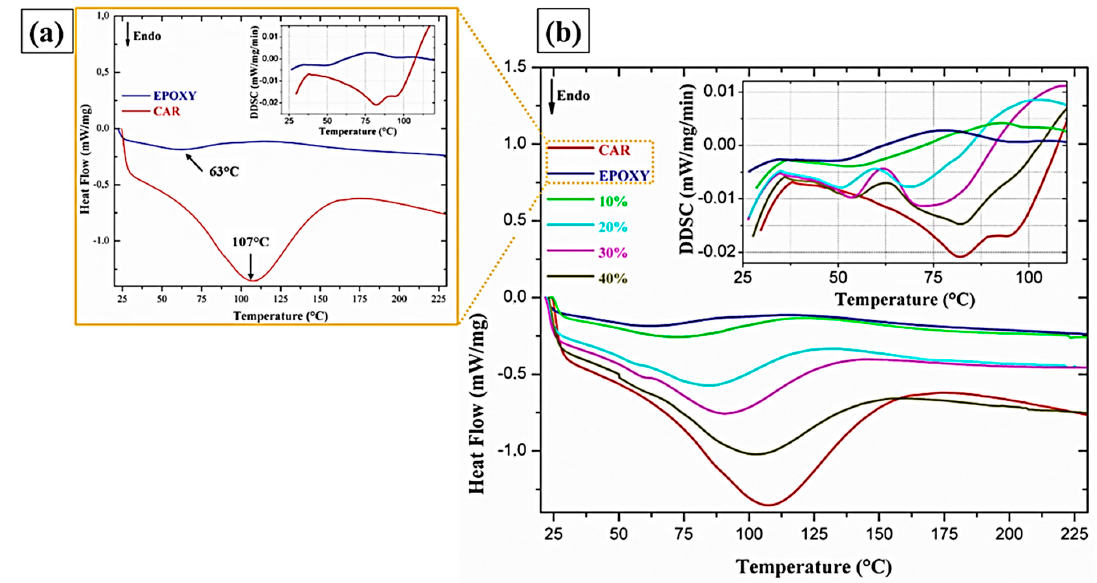
Figure 14. Differential scanning calorimetry (DSC) curves for epoxy resin and carnauba fibers ( a ) and ( b ) composites.